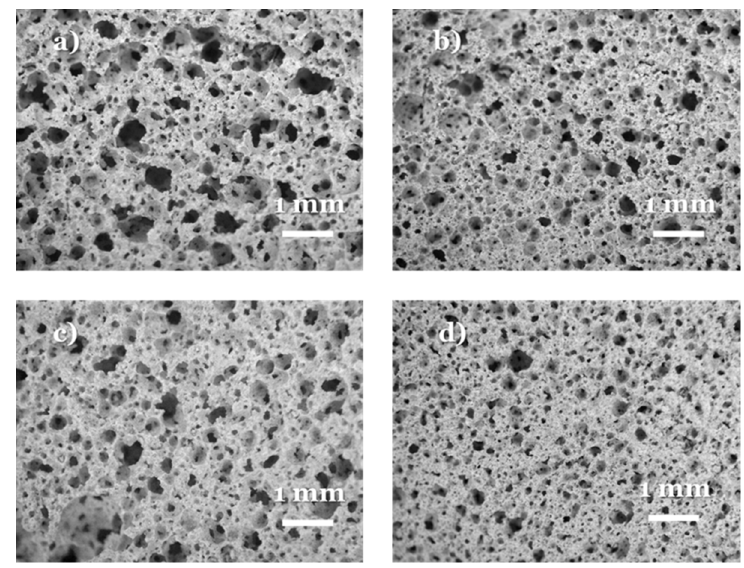
Figure 5. Micrographs of foams before and after firing at 950 °C: ( a , c ) VBA–SLG; ( b , d ) VBA–BSG.